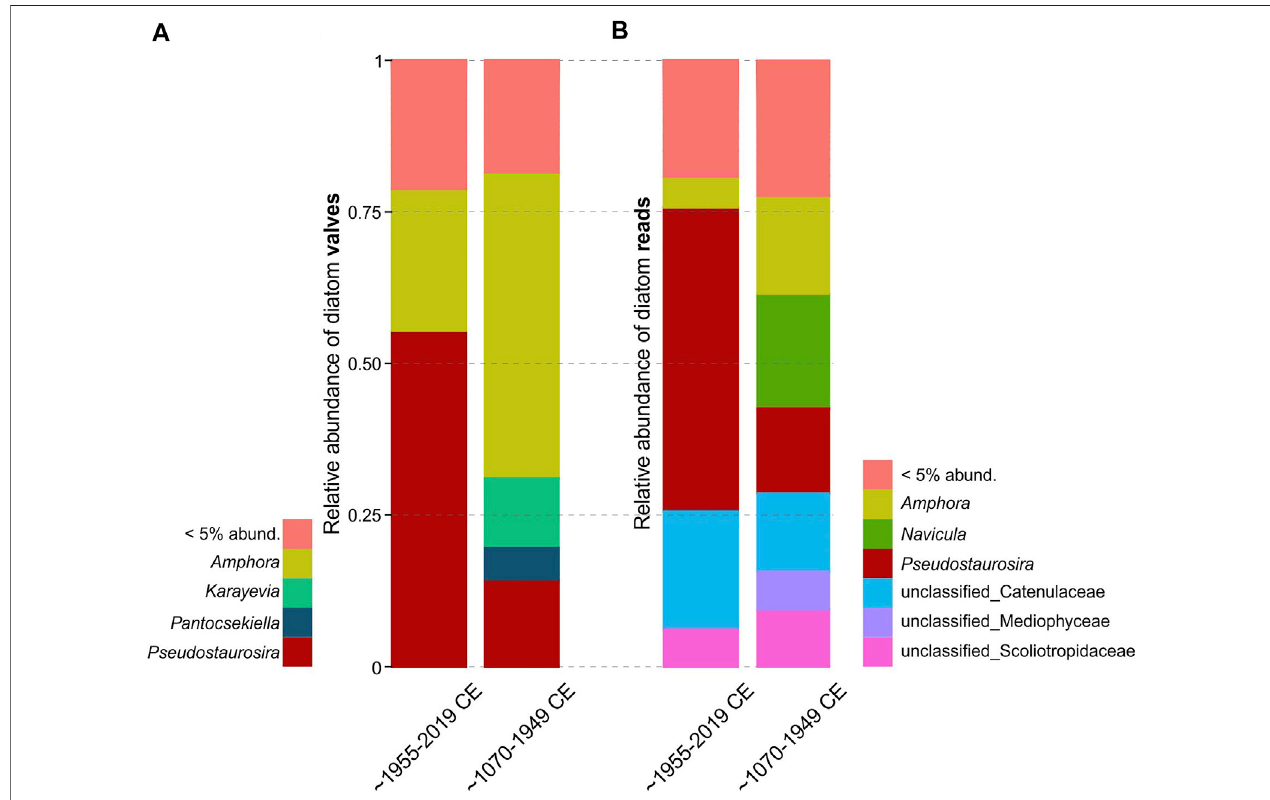
FIGURE 4 | Diatom genus level bar plots for relative abundance of valves ( (A) , valve data) and reads ( (B) , sedaDNA data). The fi rst column includes samples from the upper 10 cm of the core ( n = 10; ~1955 – 2019 CE) and the second column includes samples from the following layers until 51 cm depth ( n = 26; ~1070 – 1949 CE). This separation represents the breaking point detected by multivariate regression trees from both data sets. Most notable changes are in relative abundances of Amphora and Pseudo s taurosira .